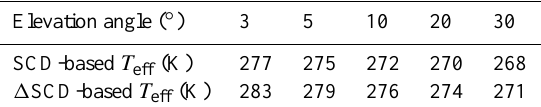
Table 1. Estimates of effective temperatures ( T eff ) for O 4 absorp- tion for an AOD (476nm) of 0.1, a solar zenith angle of 45 ◦ , and a relative azimuth angle of 180 ◦ . Surface temperature and pressure are assumed to be 292K and 986hPa, respectively, according to mean values at Tsukuba during the observation period.